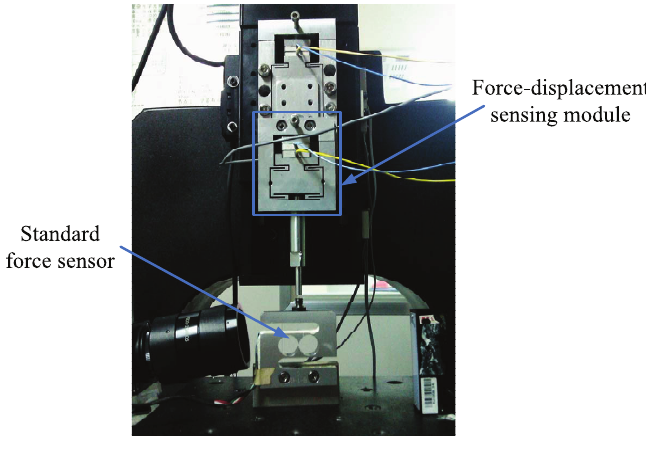
Figure 7. Calibration device of the sensing module.